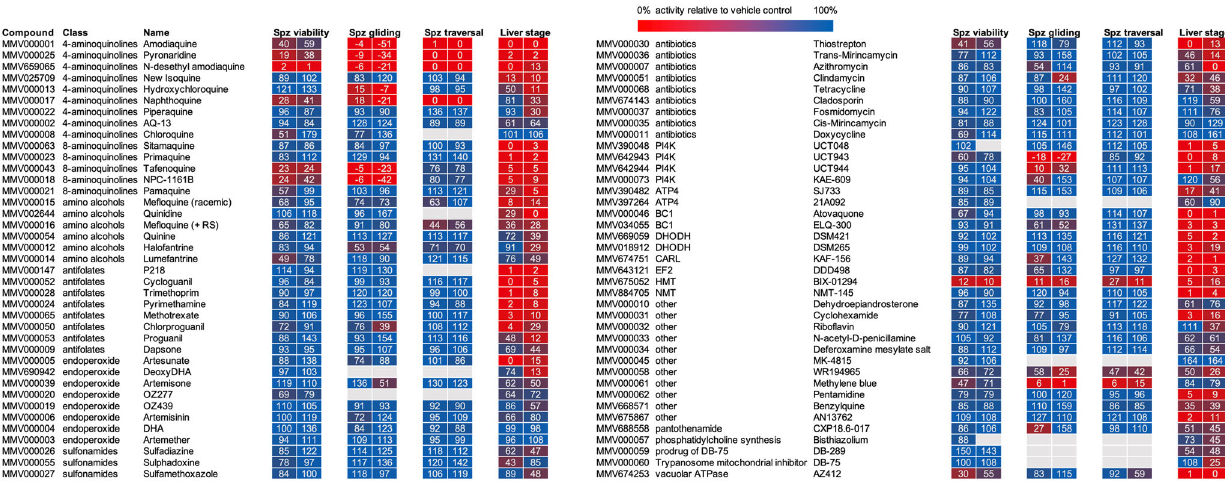
Fig. 3 Activity of marketed and experimental antimalarials in sporozoite viability, gliding, traversal, and hepatic schizogony assays. Compounds were